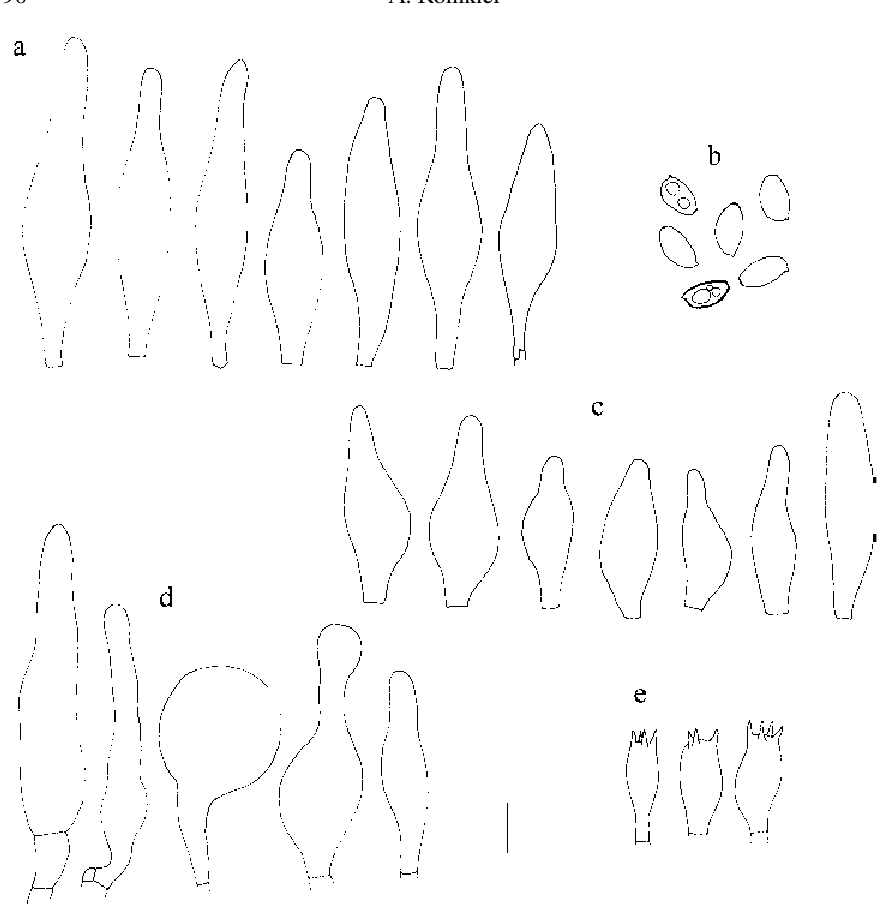
Fig. 6. Psathyrella murcida (Fr.) kits van Wav., coll. kRAM F-50386; a – pleuro cystidia, b – spores, c – cheilo cys tidia, d – caulocystidia, e – basidia; scale bar = 10